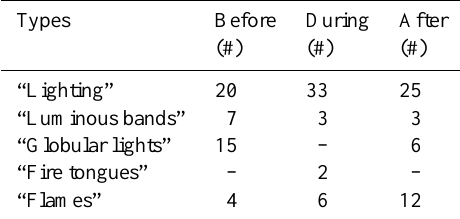
Table 5. The Montandon classification of the Aquila collection. Table 6. Altitude, shape and movement direction classifications of the Aquila